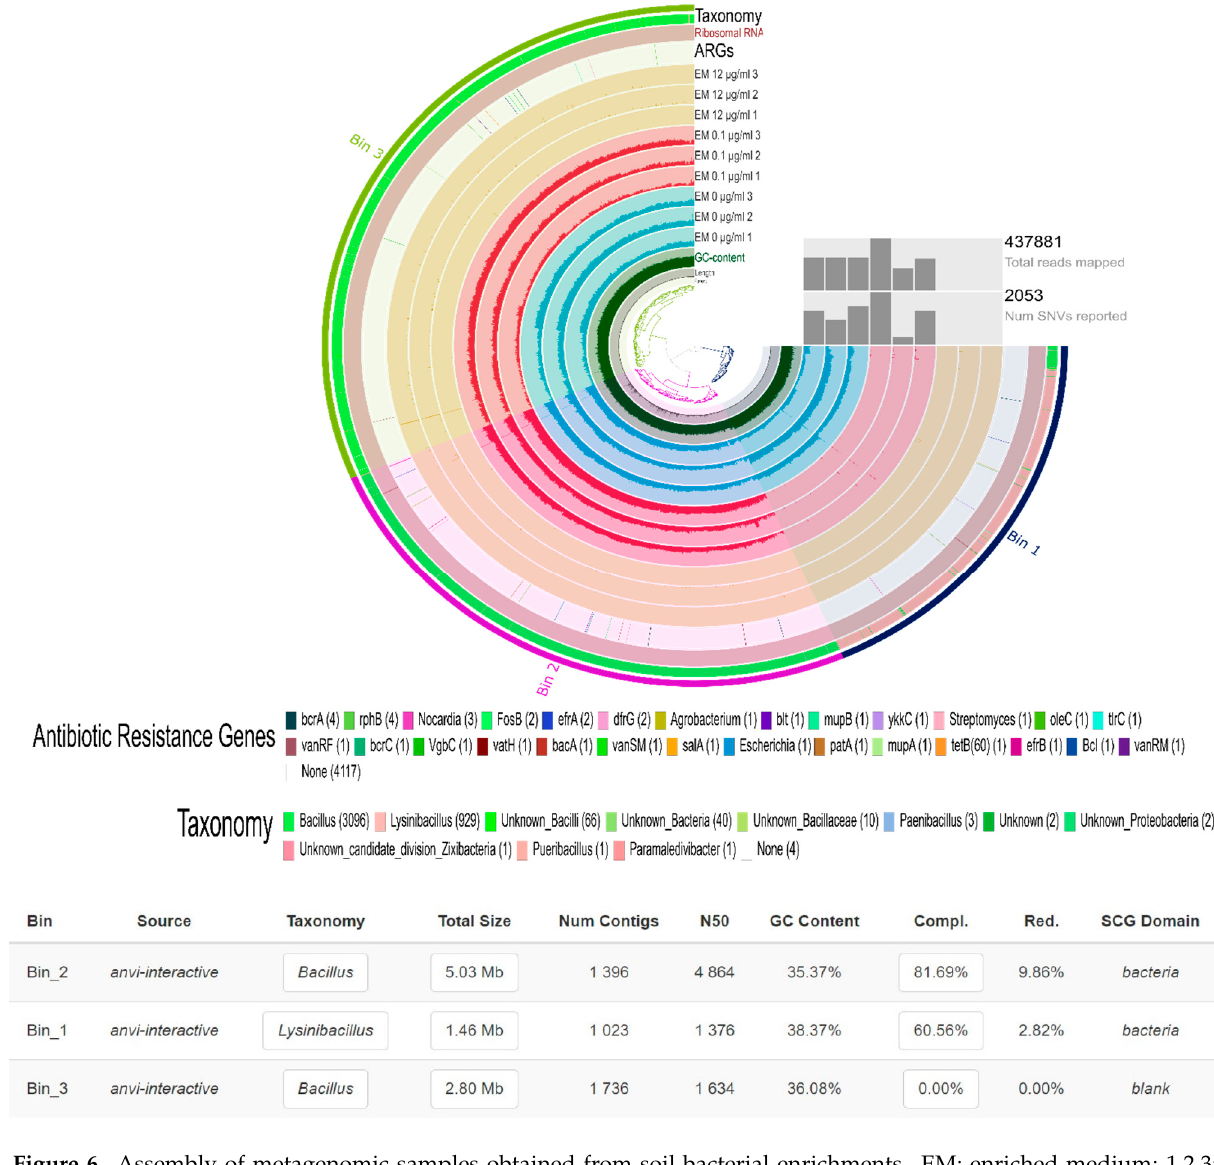
Figure 6. Assembly of metagenomic samples obtained from soil bacterial enrichments. EM: enriched medium; 1,2,3: triplicates from each condition.